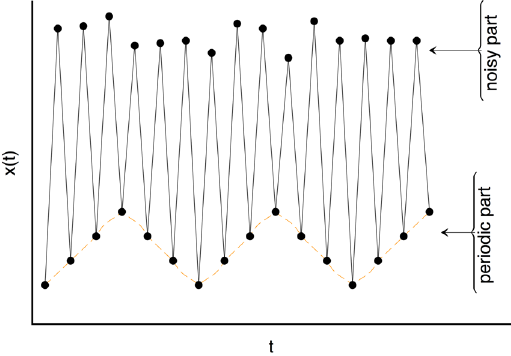
Figure 2. Cartoon series having a noisy part at even timesteps and a periodic progression part at odd timesteps: a classical VG/HVG analysis fails to capture the hidden periodic pattern, whereas such pattern can be easily extracted from G bot